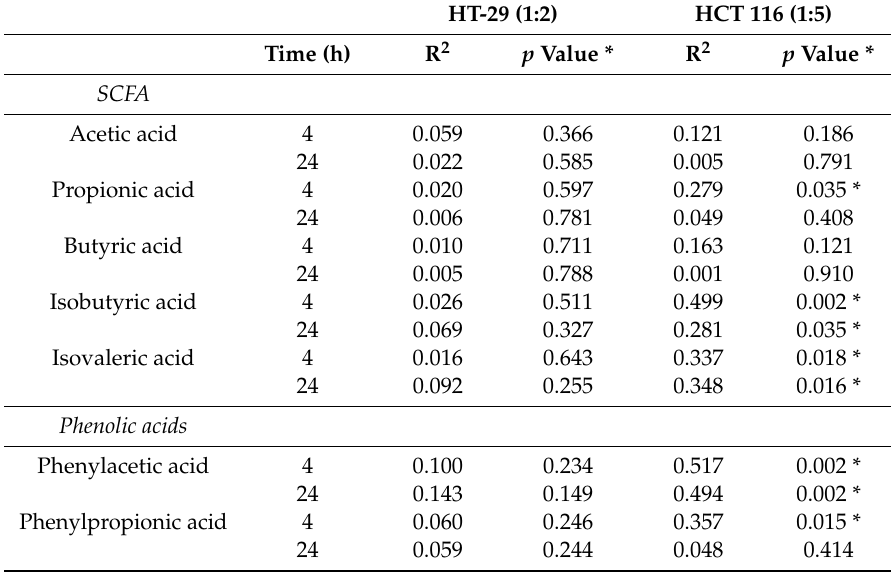
Table 4. Pearson’s correlations between FW cytotoxicity (percentage viability of HT-29 and HCT 116 cells) and concentration of short chain fatty acids (SCFA) ( µ mol / g faeces) and phenolic acids (PA) ( µ g / g faeces) in faecal samples (n = 16) collected from the intervention group volunteers. Cytotoxicity assay conditions: 1:2 ( v / v ) for FW dilution in HT-29 assay and 1:5 ( v / v ) in HCT 116 assay, and 4 and 24 h for incubation